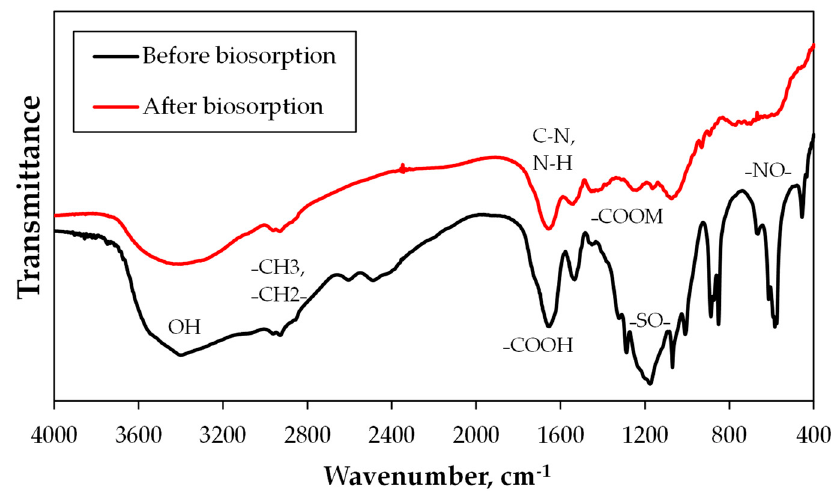
Figure 7. Vibrational stretches of functional groups in the infrared spectroscopy by Fourier transform (FTIR) analysis before and after the synthetic biosorption.